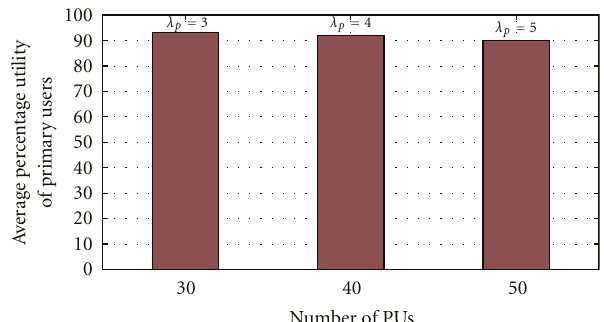
Figure 11: Percentage utility of PUs.